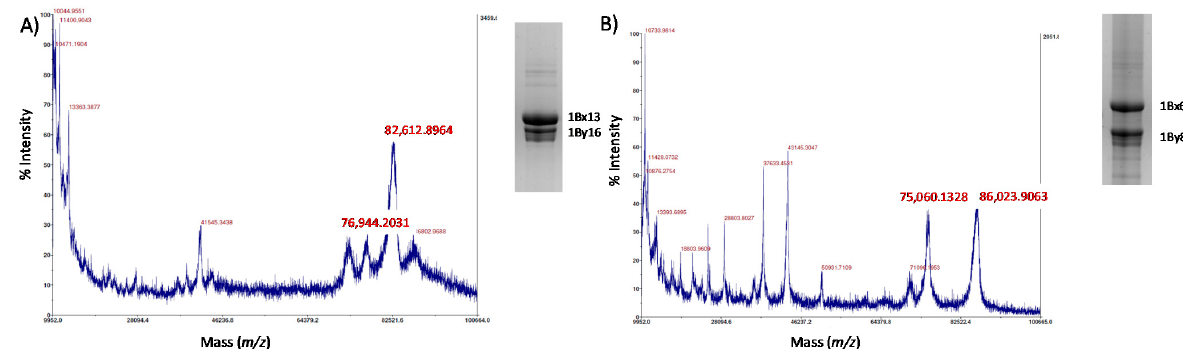
Figure 2. Examples of HMW-GS spectra of: ( A ) Russello (syn. Priziusa) and ( B ) Ruscìa (syn. Russello ibleo) durum wheat landraces. Mass spectra obtained by MALDI-TOF/MS analysis in linear mode and the corresponding bands separated by SDS-PAGE. Table 3. HMW-GS profiles assigned to the reference seeds of landraces and historical cultivars both with SDS-PAGE profiles in comparison with commercial durum wheat varieties and by MALDI-TOF/MS analyses.